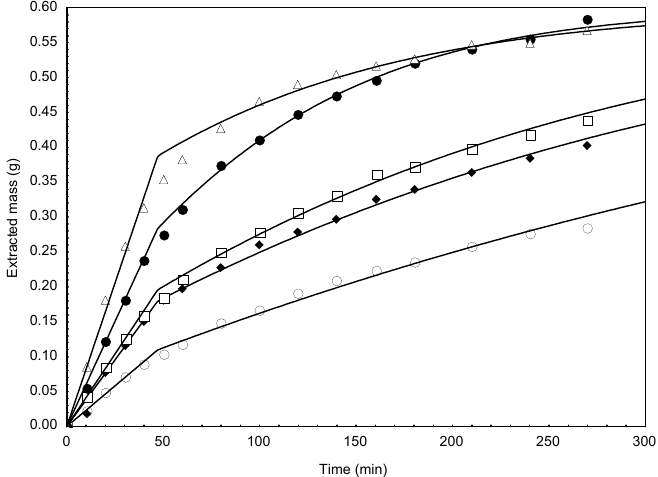
Figure 3. Experimental and calculated extraction for 30-mesh leaves of C.brasiliense